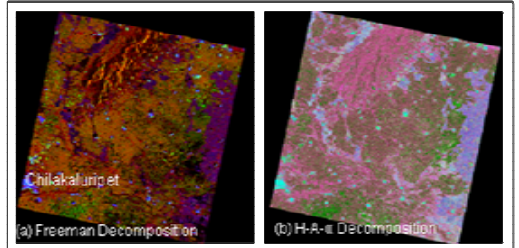
Fig 1. FCC images of Freeman (a) and